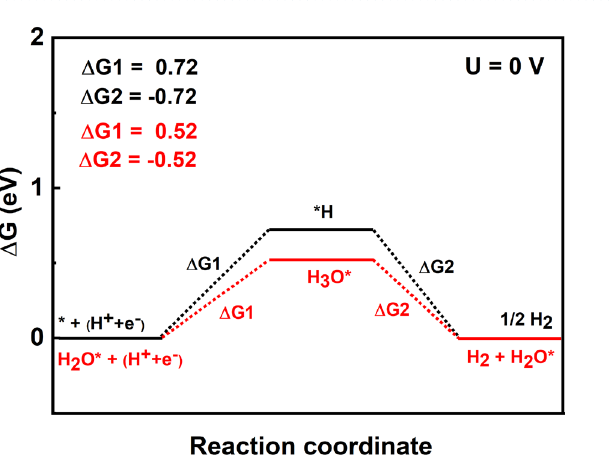
Figure 5. Optimized geometries of possible intermediates in the hydrogen evolution reaction; ( a ) *H, ( b ) * H 2 O, and ( c ) * H 3 O.